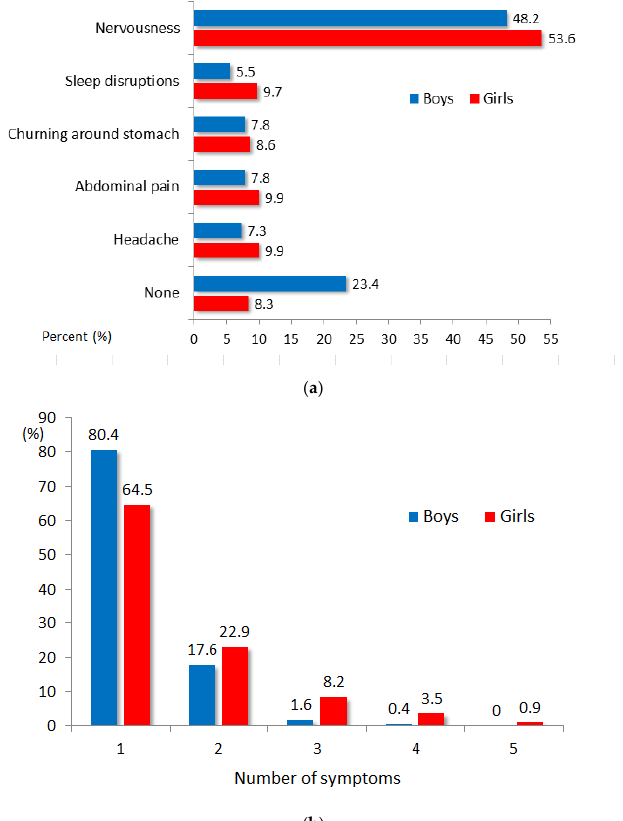
Figure 1. Frequency of psychosomatic symptoms evoked by exam/tests stress in adolescent students: ( a ) Specific symptoms; ( b ) Number of symptoms.